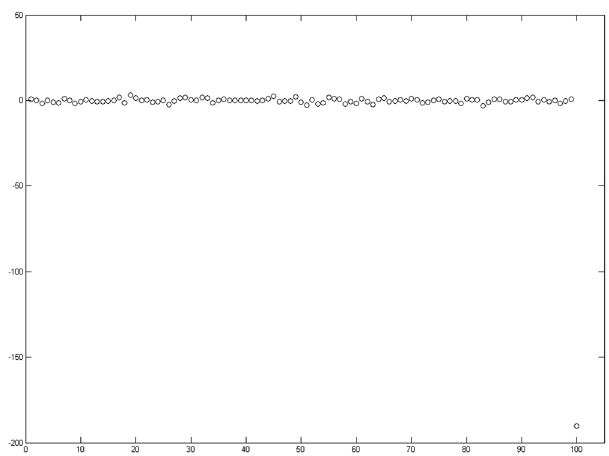
Figure 2: Example of the normal data containing one outlier observation used for Grubbs ’ test simulation.